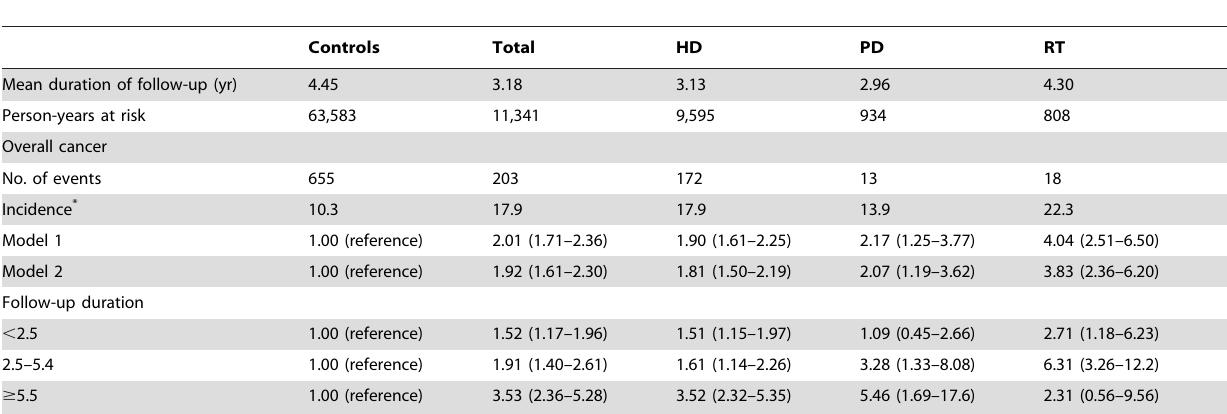
Table 2. Incidence rate and hazard ratios of overall cancer according to treatment status for patients with end-stage renal disease.